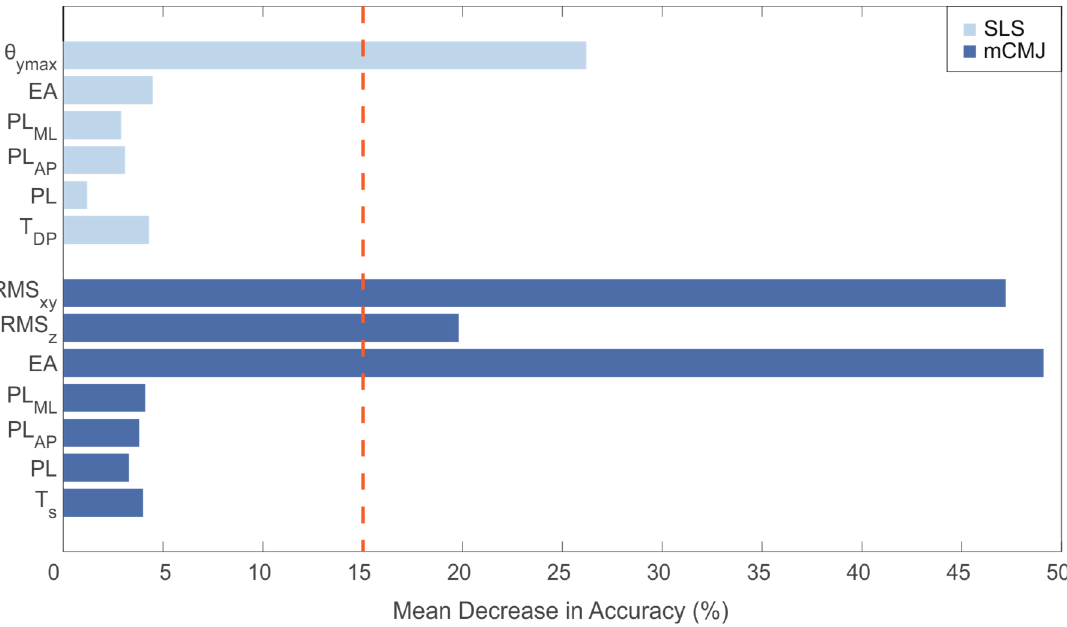
Figure 5. Mean decrease in accuracy (%) for all the used features. Dotted red line indicates the importance threshold of 15.0%.